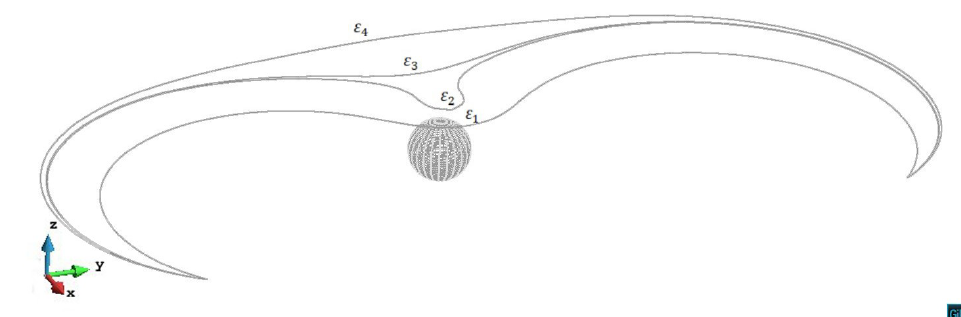
Figure 8. Process of the dislocation line gradually unpins from the precipitate stress field on the plane z / R = 1.8. The plastic strain of different steps ε 1 = 7.77 × 10 − 5 , ε 2 = 7.85 × 10 − 5 , ε 3 = 7.86 × 10 − 5 , ε 4 = 7.93 × 10 − 5 .